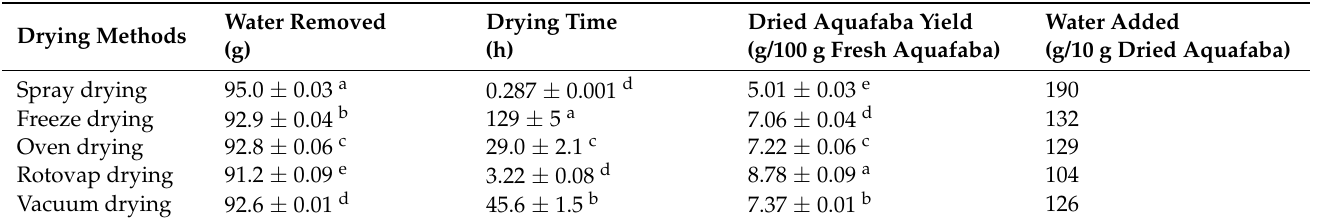
Table 2. Water removed, drying time, and dried aquafaba yield of different drying methods for 100 g fresh aquafaba and water added to rehydrate aquafaba.